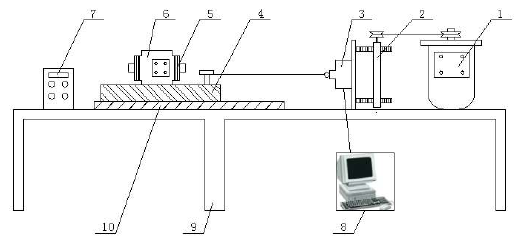
Figure 5. Schematic diagram of an experimental device for the analysis of frictional resistance between planes under the action of periodically changing normal force. 1. electric motor; 2. threaded screw device; 3. tension sensor; 4. upper sample; 5. eccentric block of shaker; 6. single axis inertial shaker; 7. inverter; 8. data collection system; 9. Shaker; 10. lower sample.